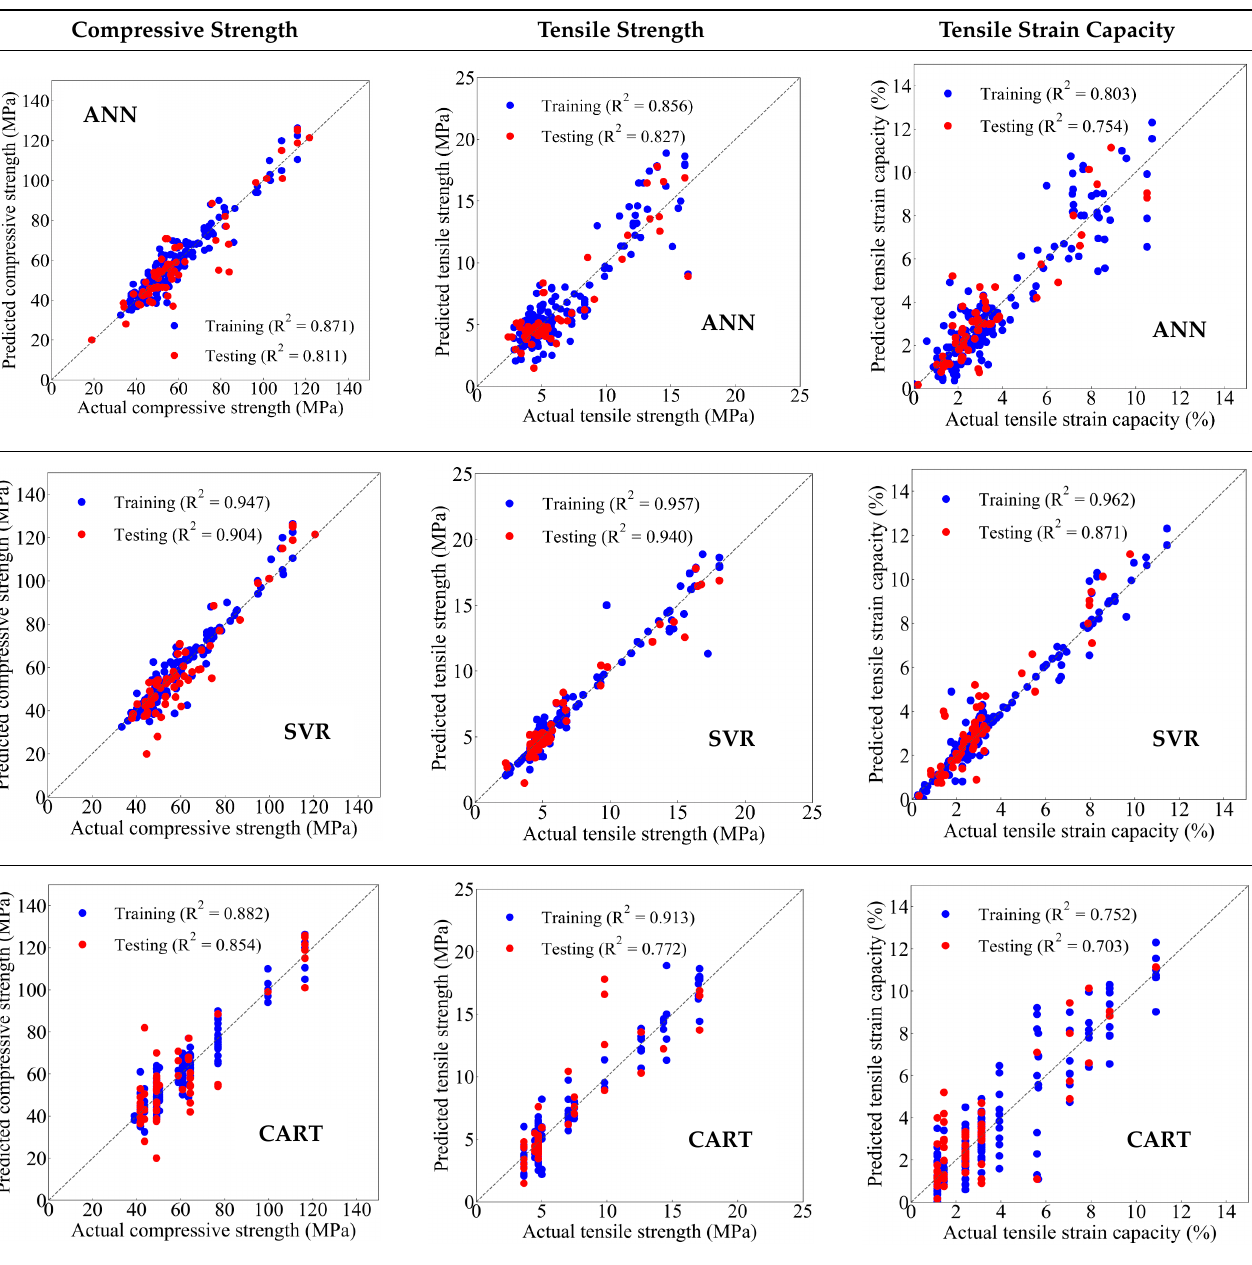
Figure 7. Learning curve for the training process (tensile strength) using: ( a ) ANN, ( b ) SVR, ( c ) CART, and ( d ) XGBoost.